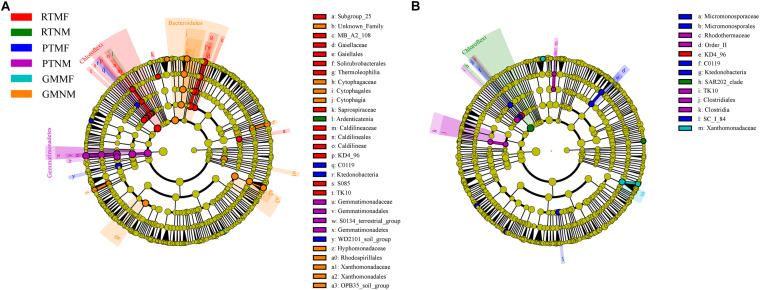
A linear discriminant analysis effect size method identifies the significantly different abundant taxa of bacteria in 0–10 cm (A) and 10–20 cm soil layer (B) from all treatments.